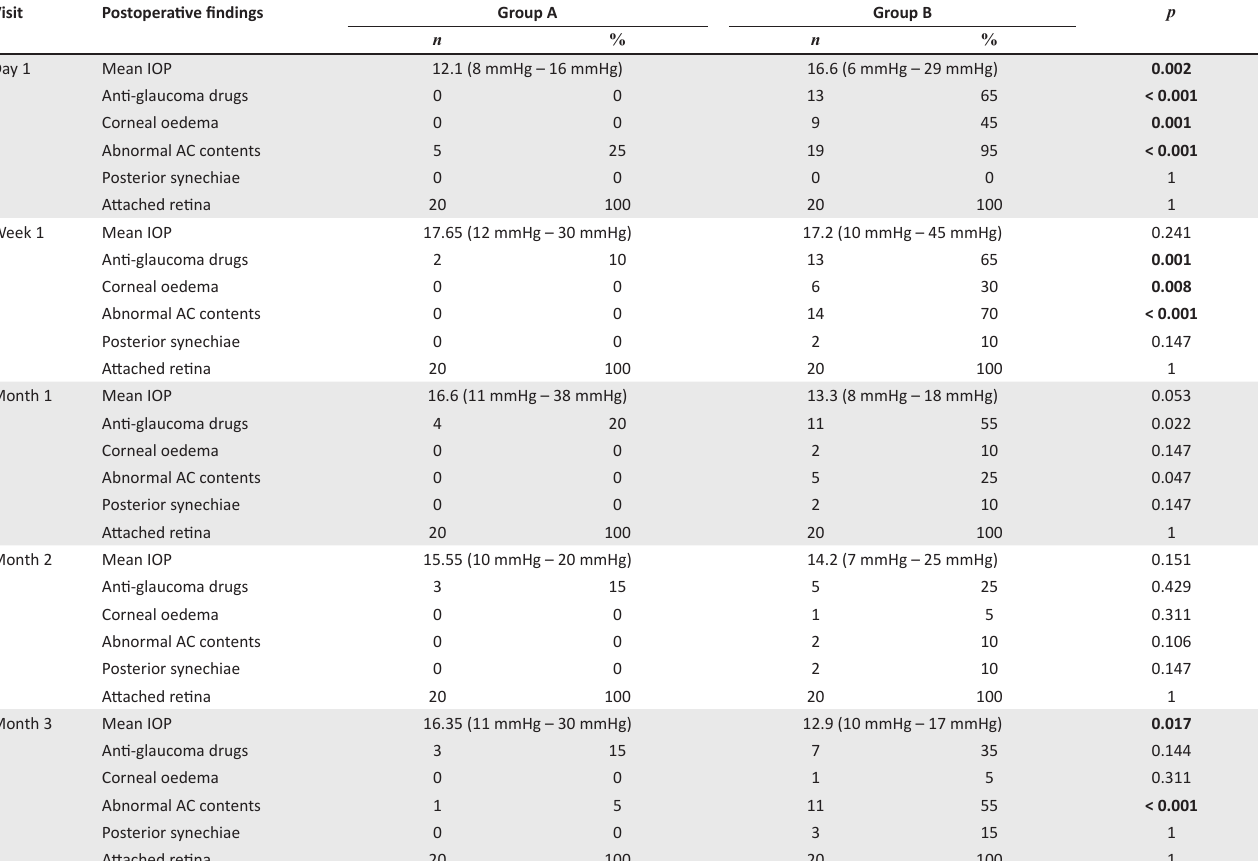
TABLE 3: First procedure postoperative data. Visit Postoperative